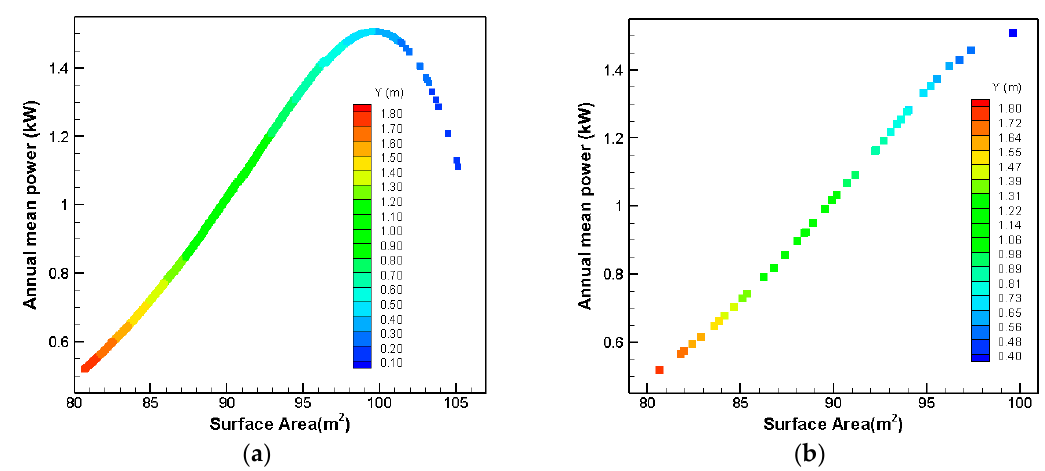
Figure 22. Optimization results of the upside filleted geometry: ( a ) all results, and ( b ) Pareto front.